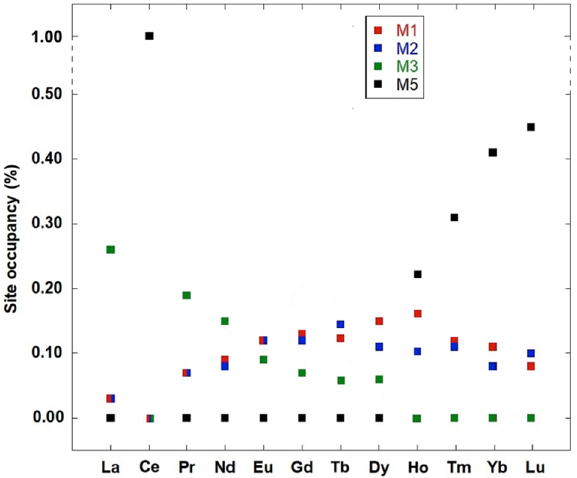
Figure 4. Distribution of RE cations within M1, M2, M3, and M5 sites in available Ca 9 RE (PO 4 ) 7 struc- ture refinements; data from [6], with the exception of Ce [30], Tb and Ho [32], and Lu [31].